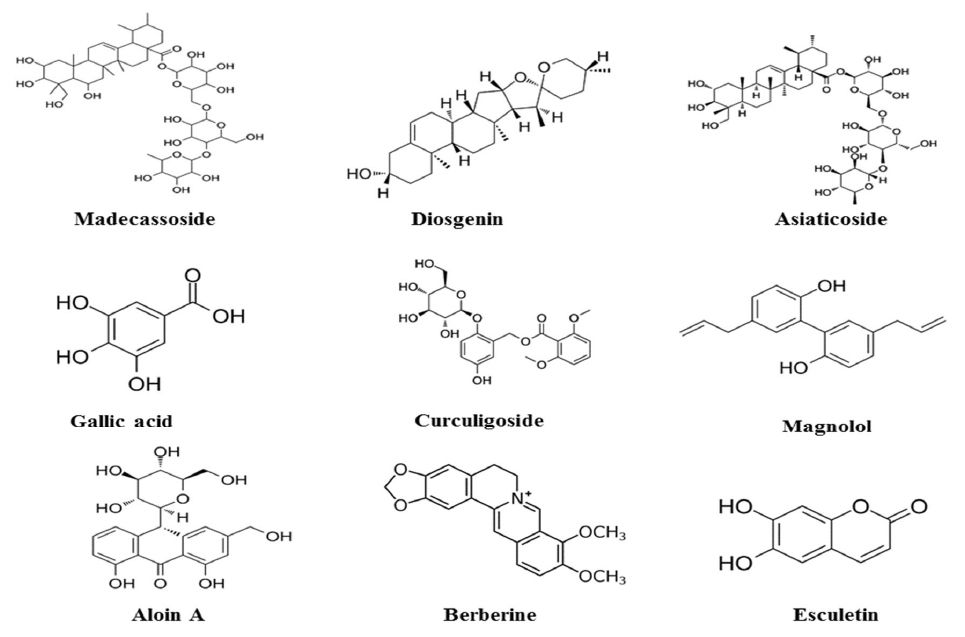
Figure 1. Chemical formulas for natural compounds.